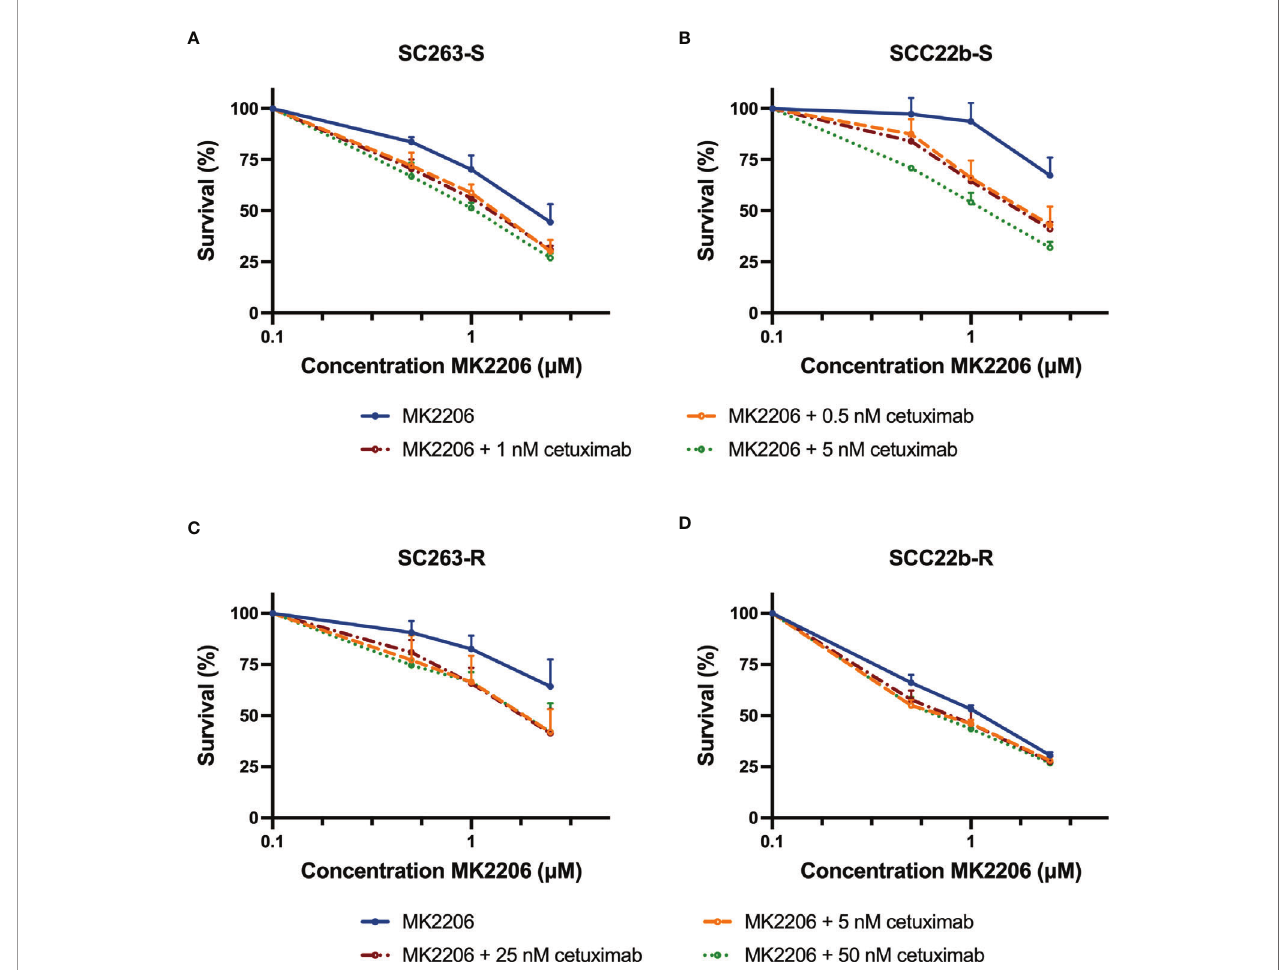
FIGURE 4 | The cytotoxic effect of cetuximab for 168h with MK2206 added during the last 72h of treatment. Dose-response curves for the cetuximab sensitive HNSCC cell lines SC263-S (A) and SCC22b-S (B) show a synergistic interaction. Regarding the acquired cetuximab resistant variants, dose-response curves indicate a synergistic and additive effect in SC263-R (C) and SCC22b-R (D) , respectively. Survival curves were corrected for the cytotoxic effect of cetuximab alone. Cells were treated with fi xed concentrations of cetuximab, which were based on the outcome of previous monotherapy experiments. Suf fi x -S: cetuximab sensitive cell line and suf fi x -R: acquired cetuximab resistant cell